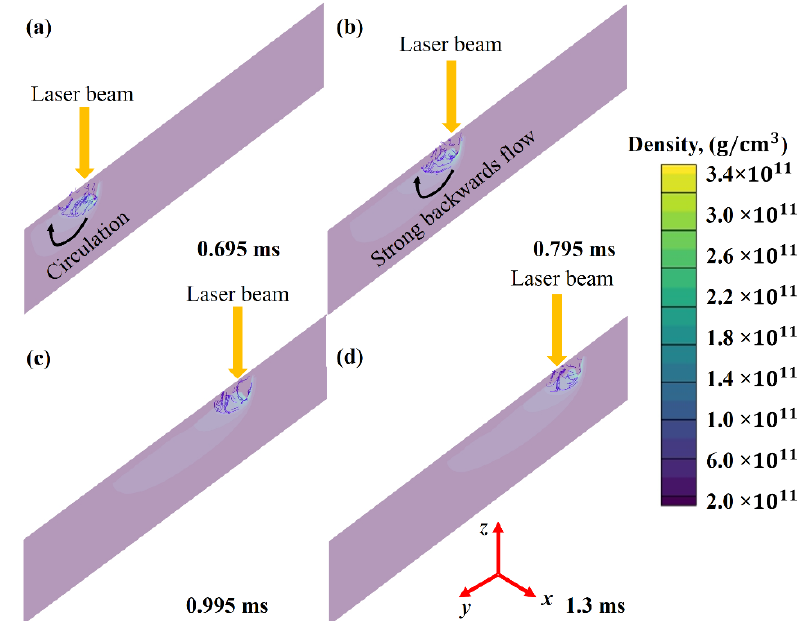
Figure 5. Melt flow stream traces formation at various time intervals ( a ) 0.695 ms, ( b ) 0.795 ms, ( c ) 0.995 ms and ( d ) 1.3 ms. ( c ) 0.995 ms and ( d ) 1.3